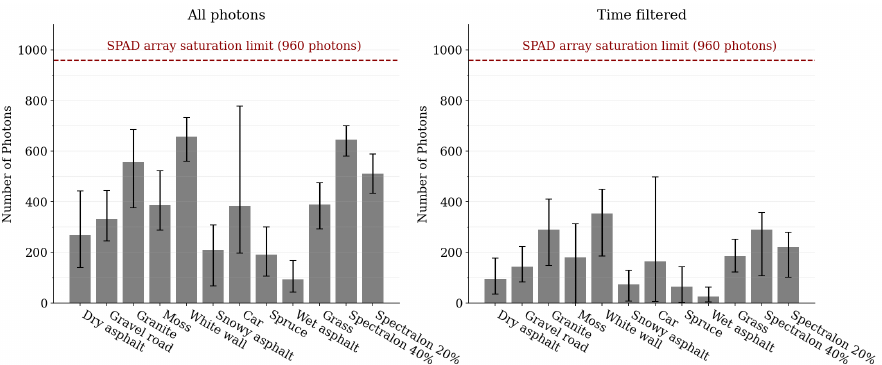
Figure 9. The average photon count for each sample class (total photon count over all wavelength channels). The left-hand side shows the photon count during the whole exposure period while the right-hand side shows the photon count for the target return pulse (number of detections where the timer values are in the range [ µ dist . − 3 σ fw , µ dist . + 3 σ fw ] ). The error bars denote the maximum and minimum photon count within the sample